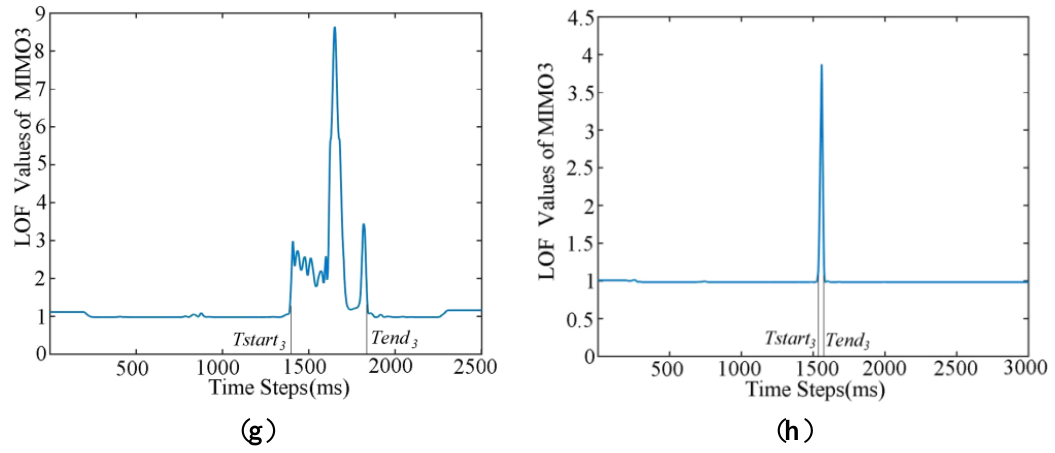
Figure 2. An example of action boundary computation by the LOFs of MIMOs: ( a , c , e , g ) Action 1; ( b , d , f , h ) Action 2; ( a , b ) Two actions’ MIMO subplots with their boundaries denoted by the vertical bars; ( c – h ) Two actions’ LOF subplots with their boundaries denoted by the vertical